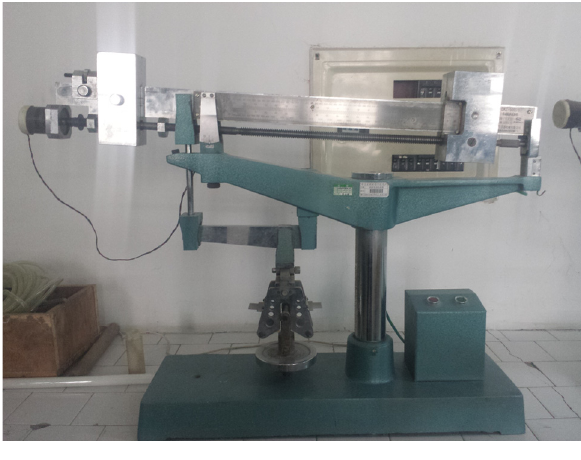
Figure 1: Flexure